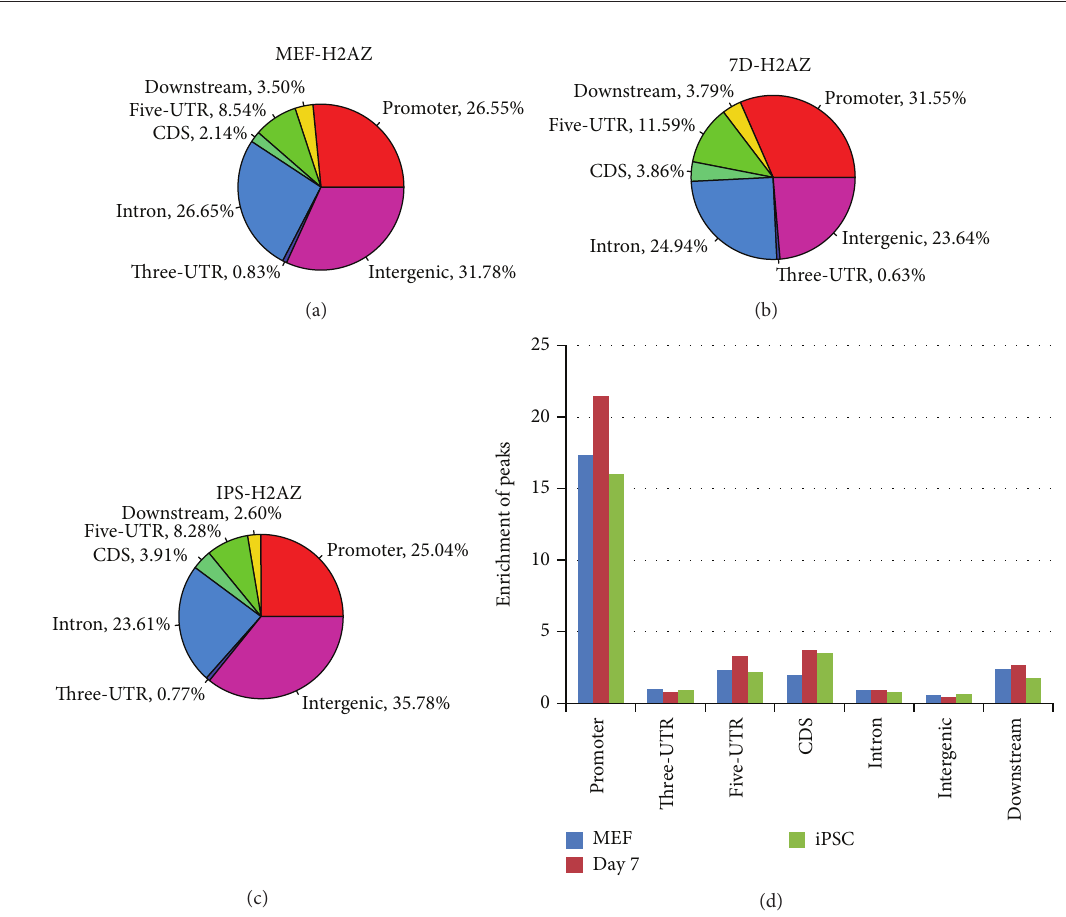
Figure 1: Distribution and enrichment of H2A.Z in different gene regions. (a–c) Mapping of peaks representing H2A.Z occupancy on a genome-wide scale relative to RefSeq mouse genes. “Promoter” and “downstream” are defined as 2kb of 5 󸀠 or 3 󸀠 flanking regions. The “intergenic” region refers to all locations other than the promoter, 5 󸀠 UTR, CDS, intron, 3 󸀠 UTR, or “downstream” (d). Relative enrichment of H2A.Z peaks in gene elements defined as (number of ChIP sequencing peaks in one region/total number of ChIP sequencing peaks in genome)/(number of whole genome bases in one region/total number of whole genome